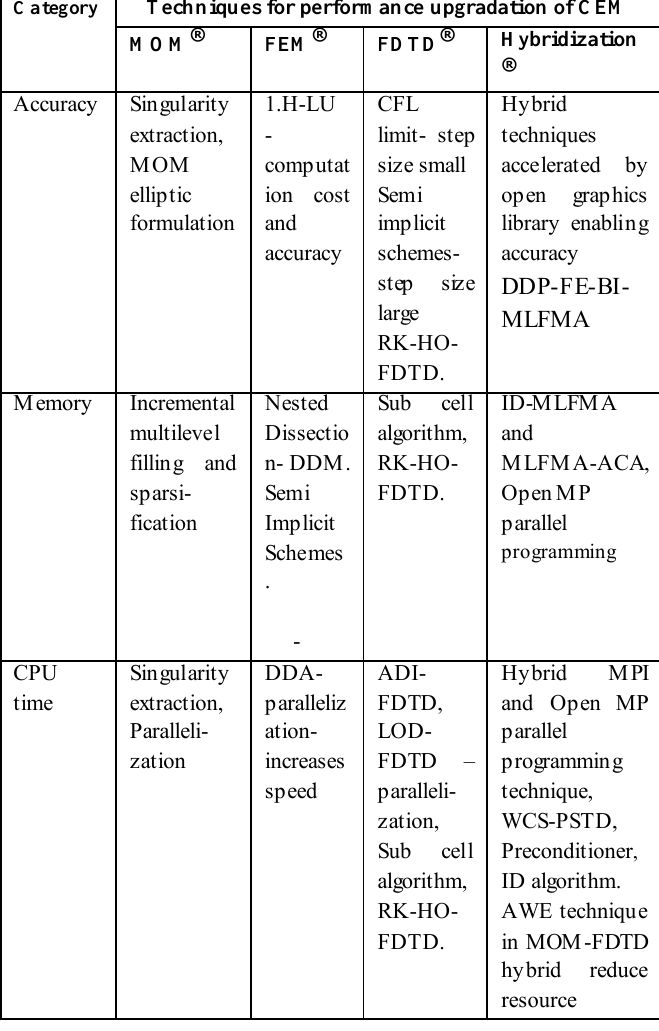
TABLE 2: Techniques for performance up gradation of CEM